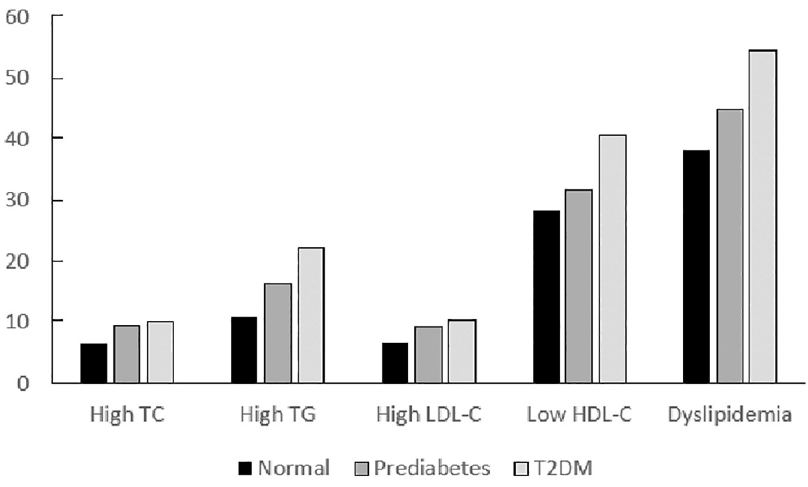
Fig 1. Prevalence of high TC, high TG, high LDL-C, low HDL-C, and dyslipidemia according to diabetic progression stages. Abbreviations: TC, total cholesterol; TG, triglyceride; LDL-C, low-density lipoprotein cholesterol; HDL-C, high-density lipoprotein cholesterol; T2DM, type 2 diabetes